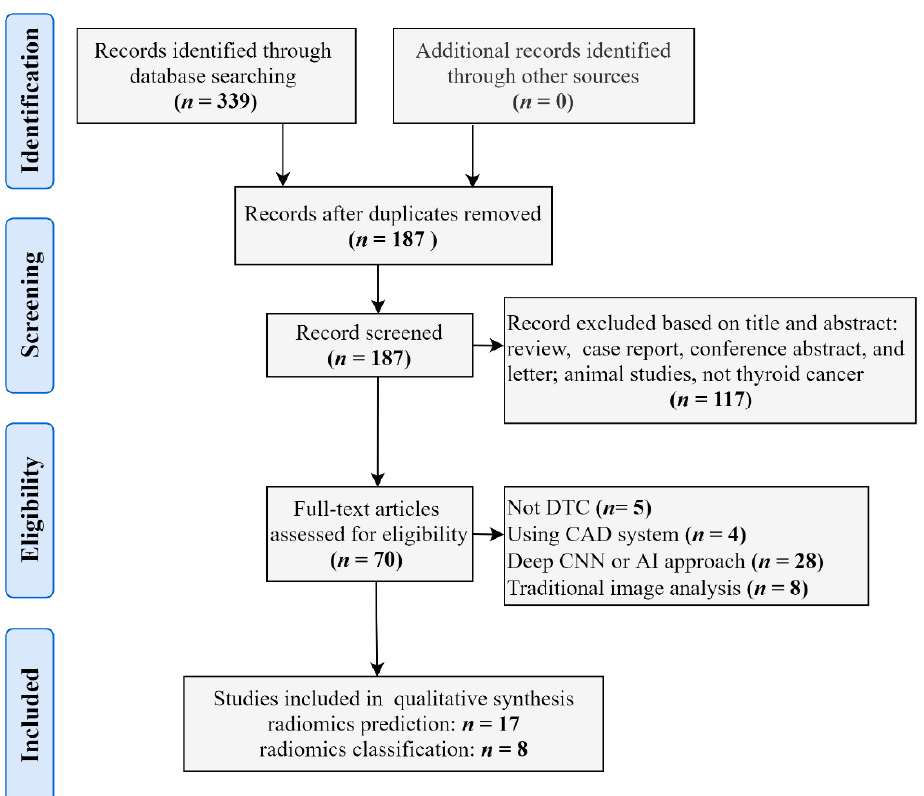
Figure 2. Flow diagram for the identification and exclusion of studies in radiomics application in differentiated thyroid cancer and nodules. Abbreviations: DTC—differentiated thyroid cancer; CAD—computer-aided detection; CNN—convolutional neural networks; AI—artificial intelligence.